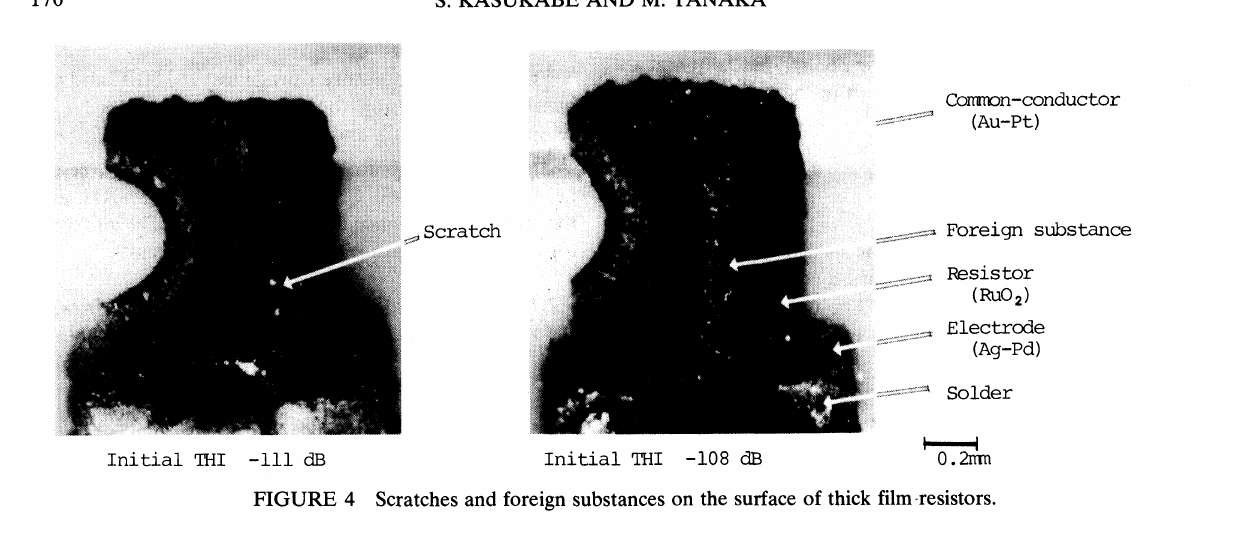
FIGURE 4 Scratches and foreign substances on the surface of thick film-resistors.